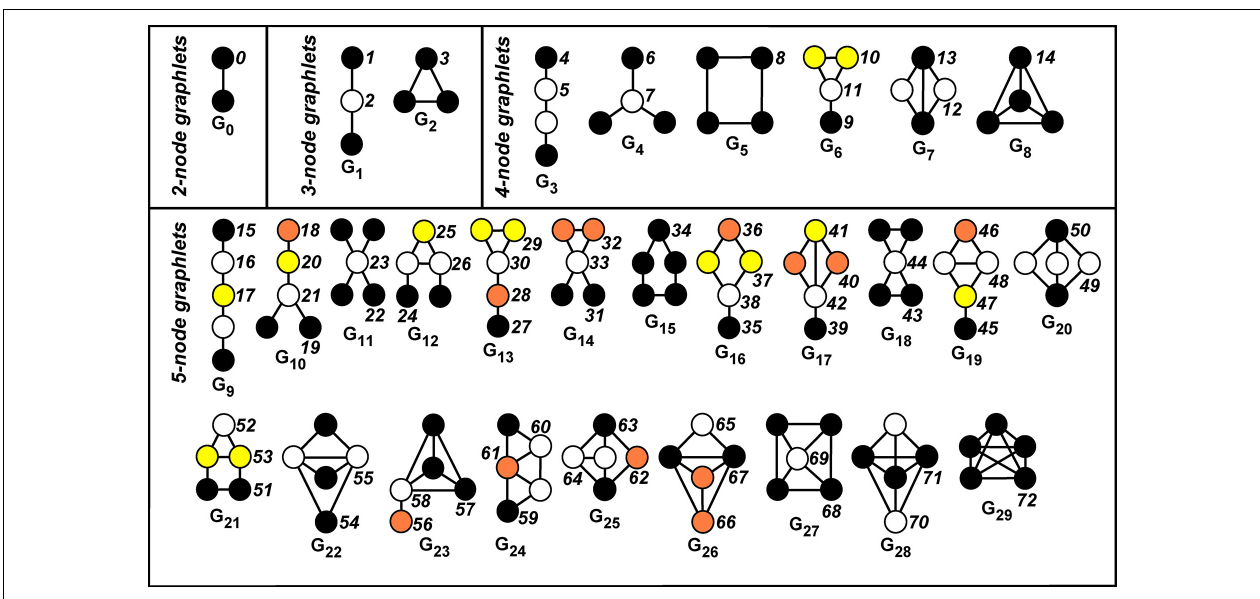
FIGURE 1 | Automorphism orbits 0,1,2, ... ,72 for the 30 up to five-node graphlets G 0 , G 1 , ... , G 29 . Nodes belonging to the same orbit of a graphlet have the same color. The non-redundant orbits we take into account are 0, 1, 2, 4, 6, 8, 9, 10, 11, 12, 13, 15, 18, 19, 22, 24, 25, 27, 29, 30, 31, 32, 33, 34, 35, 36, 37, 39, 40, 41, 42, 43, 45, 46, 48, 49, 50, 51, 52, 53, 54, 55, 56, 57, 58, 59, 60, 61, 62, 63, 64, 65, 66, 67, 68,